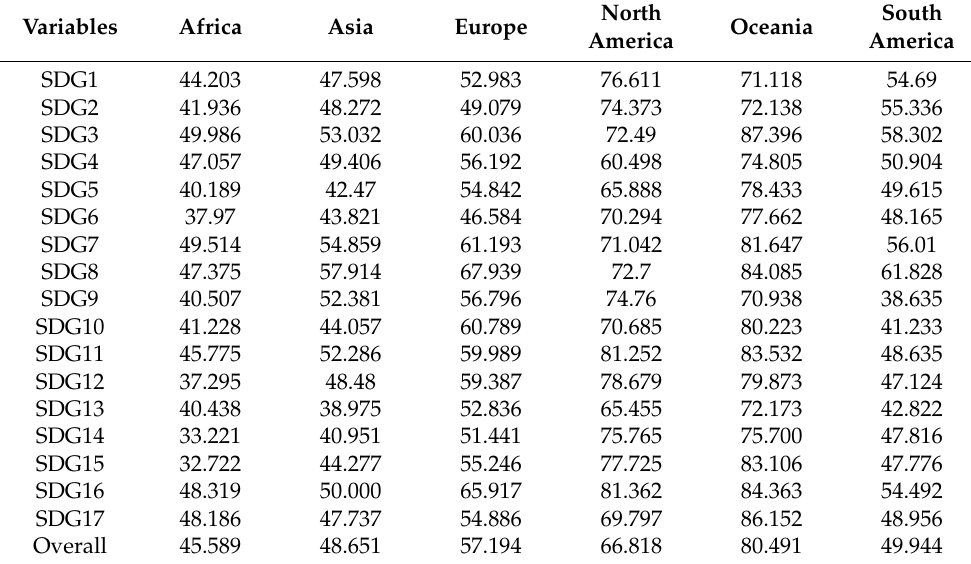
Figure 1. Most disclosed SDGs. Table 7 shows the reported SDGs in relation to the different geographical regions. Table 7. SDG distribution by region.